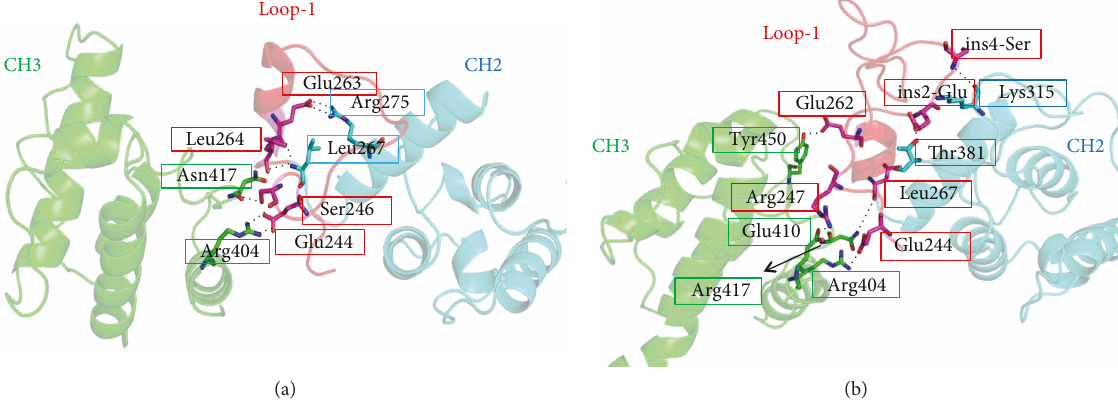
Figure 5: The hydrogen bonds formed between the CH2 and CH3 interface for wild plastin-3 system (a) and Glu249_Ala250ins12 system (b), respectively. The protein is represented with colored cartoon, red for the LOOP-1 region, blue for CH2 domain, and green for CH3 domain, respectively. Residues involved in the h-bonds interactions are highlighted with